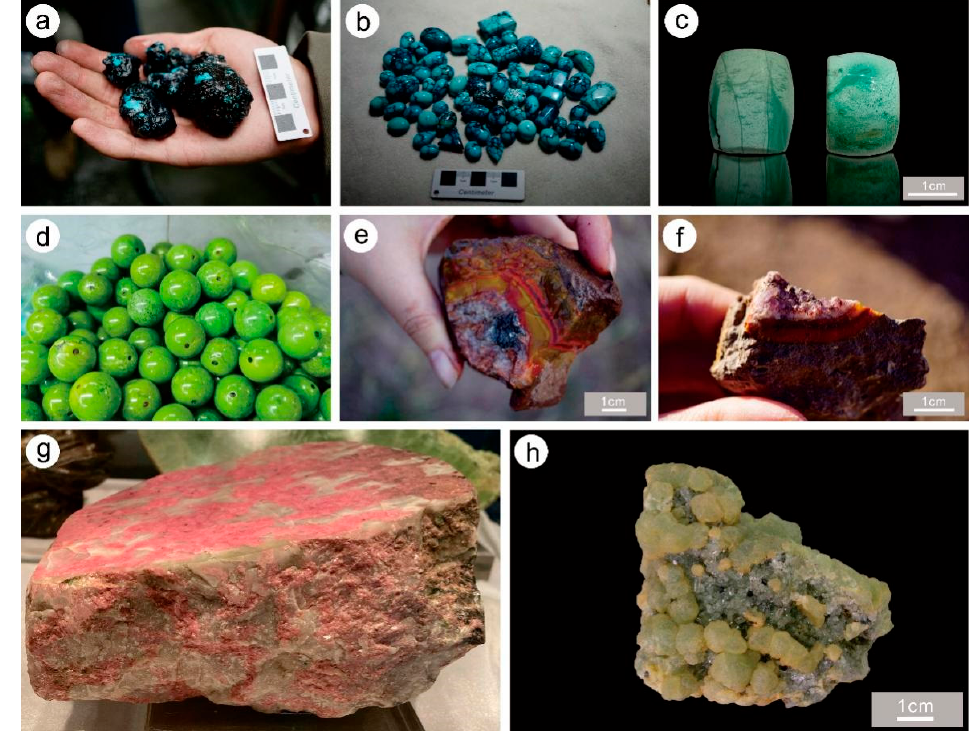
Figure 5. ( a ) The turquoise ore stones from Dongzigou mining in Zhushan, Hubei province. ( b ) The turquoise from Ankang County in Shaanxi province. ( c ) The Zhushan turquoise with “raindrops” pattern, Hubei. ( d ) The new variety of turquoises from Hubei province show yellow-green color with high saturation, and these beads are about 3 cm in diameter. ( e ) The Warring States Red Agate with red, yellow, and brown zonations, Hebei province. ( f ) The rocks containing amethyst and agate from Hebei province. ( g ) The pink-bright red rhodonites occur in white quartz as a homogeneous bulk. ( h ) The high-quality prehnite from Yunnan with yellow-green. (Figure 5g is collected in the Geological Museum of China).